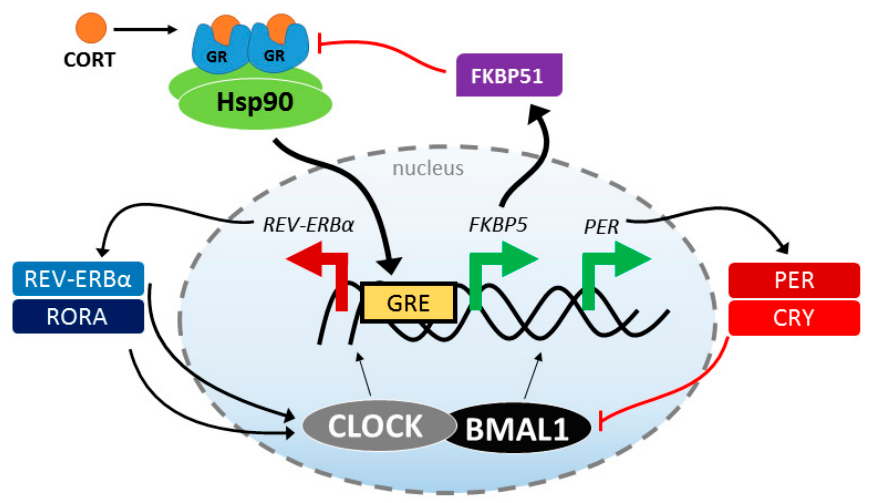
Figure 2. Schematic of the feedback between the molecular clock and stress response systems. Stress produces CORT, which binds to the GR/Hsp90 heterocomplex. GR forms a homodimer and translocate to the nucleus where it binds the glucocorticoid response elements in the promoter region. This leads to increased FKBP5/FKBP51, which slows GR activity, and increased PER expression, a component of the negative arm of the circadian clock; at the same time, REV-ERB α , a positive arm protein is down regulated.